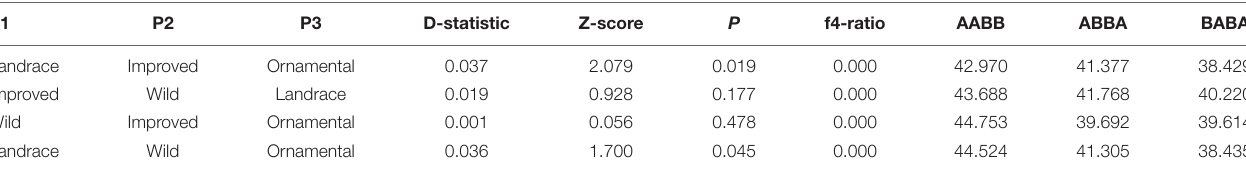
FIGURE 3 | Admixture analysis for (A) K = 2 and (B) K = 4, showing the assignment probability of individuals from C. pepo ssp. fraterna (Wild), C. pepo ssp. ovifera (Orn.), and C. pepo ssp. pepo Mexican landraces (Landraces) and improved cultivars (Improved). Each color represents a genetic cluster. TABLE 4 | Results of ABBA-BABA test to detect introgression using 1,721 SNPs between all possible arrangements between lineages, considering C. argyrosperma ssp. sororia as